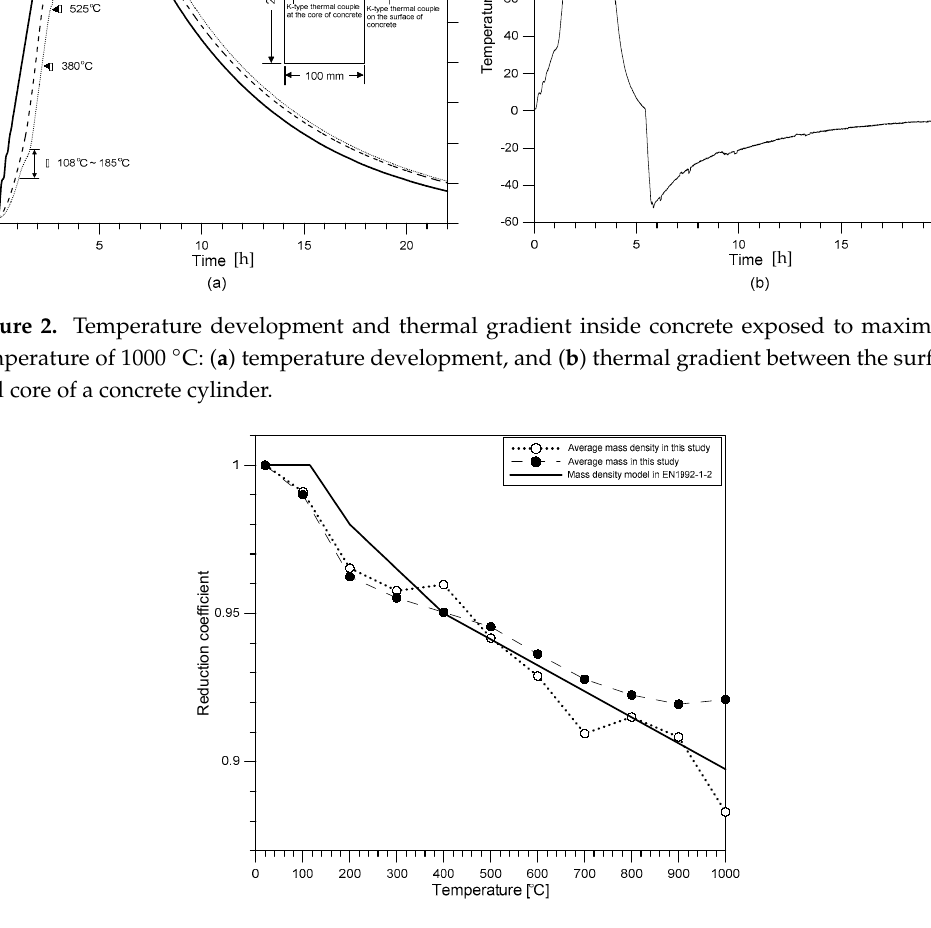
Figure 3. Variation of the relative mass and mass density of concrete with increasing temperature.